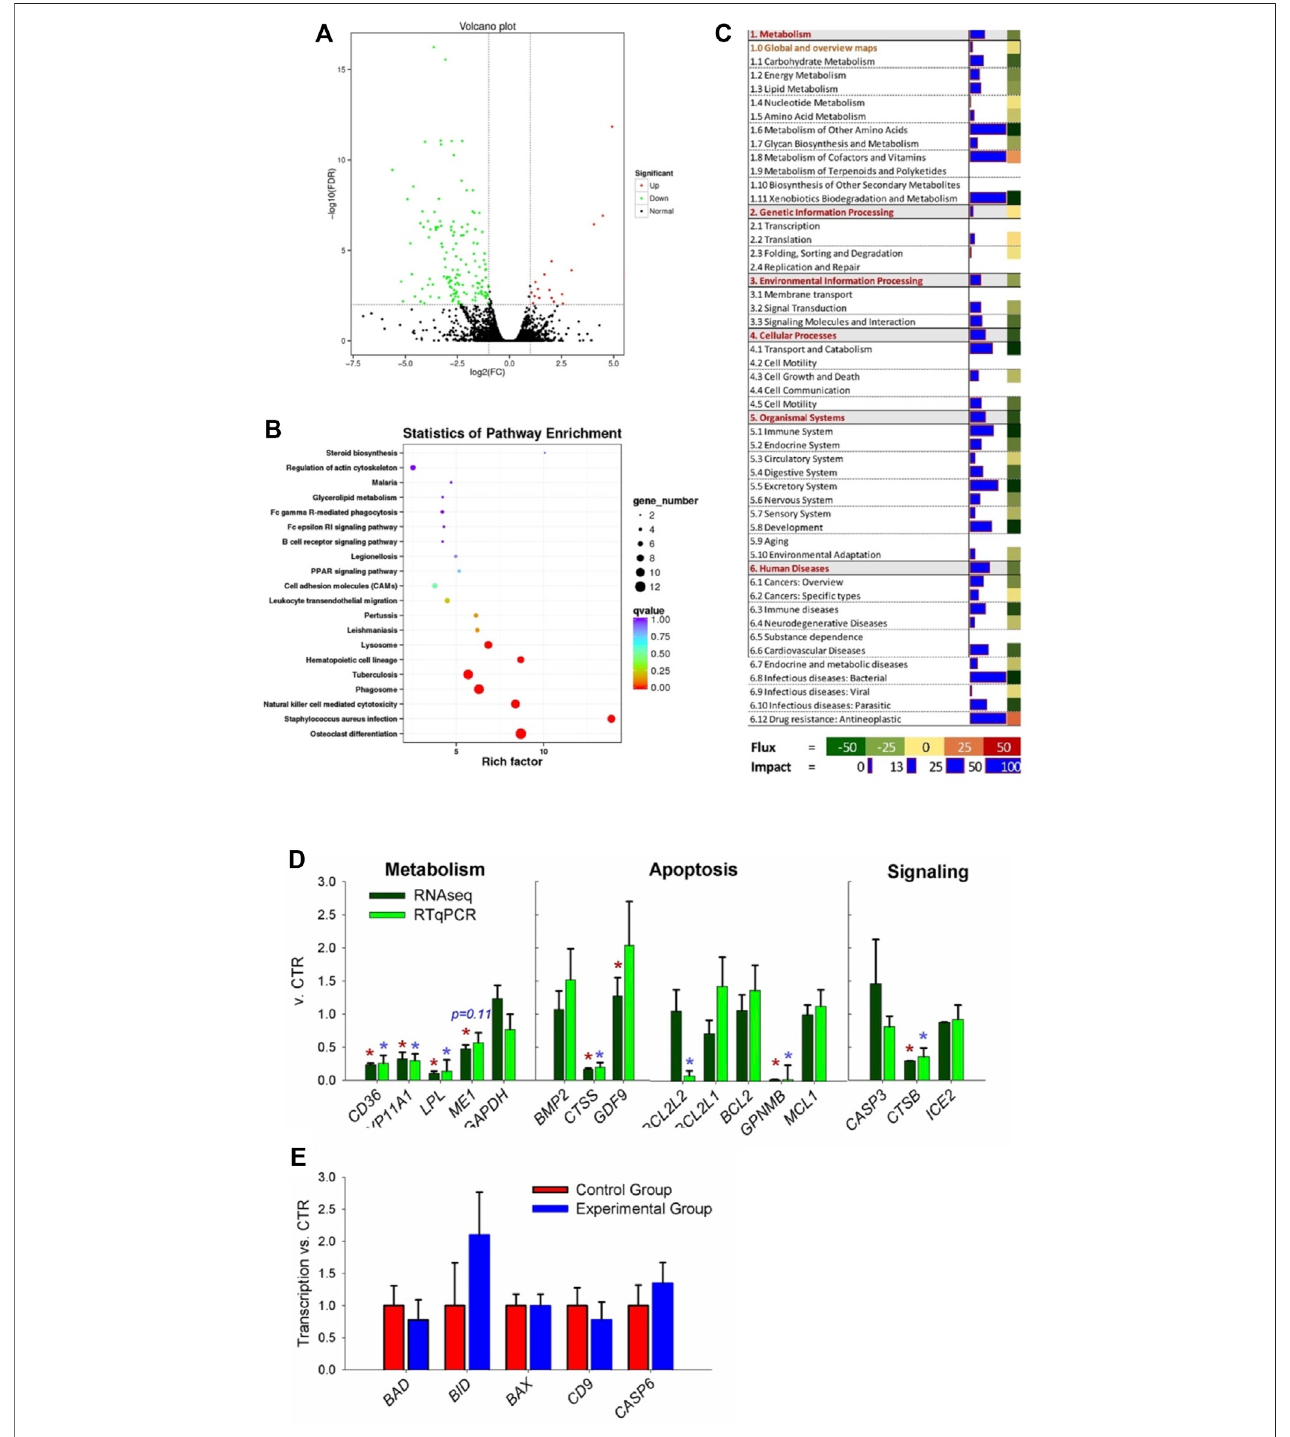
FIGURE3| Transcriptomicanalysisofovarytissuesinrabbitwherecoprophagywasprevented(i.e.,experimentalgroup)andacontrolgroup(n=3pergroup). (A) Volcano plot of differentially expressed genes (expression ratio experimental/control group). (B) KEGG pathways enriched ( p < 0.05) in DEGs by using KOBAS. (C) SummaryofmaincategoriesofKEGGpathwaysgeneratedbyusingtheDynamicImpactApproach.Bluehorizontalbarsdenoteimpact(largerthebar,largertheimpact) and squares besides the blue horizontal bars denote fl ux of the pathway that can be induced or inhibited as indicated in the bottom legend. (D) RNA-seq vs. RT- qPCR for transcripts selected among the ones related to metabolism, apoptosis, and signaling pathways. (E) Additional transcripts measured by RT-qPCR involved in apoptosis and related to cathepsin B